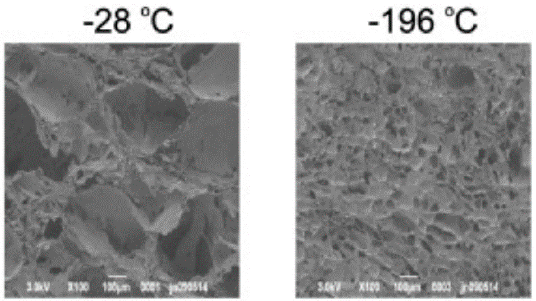
− 28 ◦ C and − 196 ◦ C. Source: Voda et al.